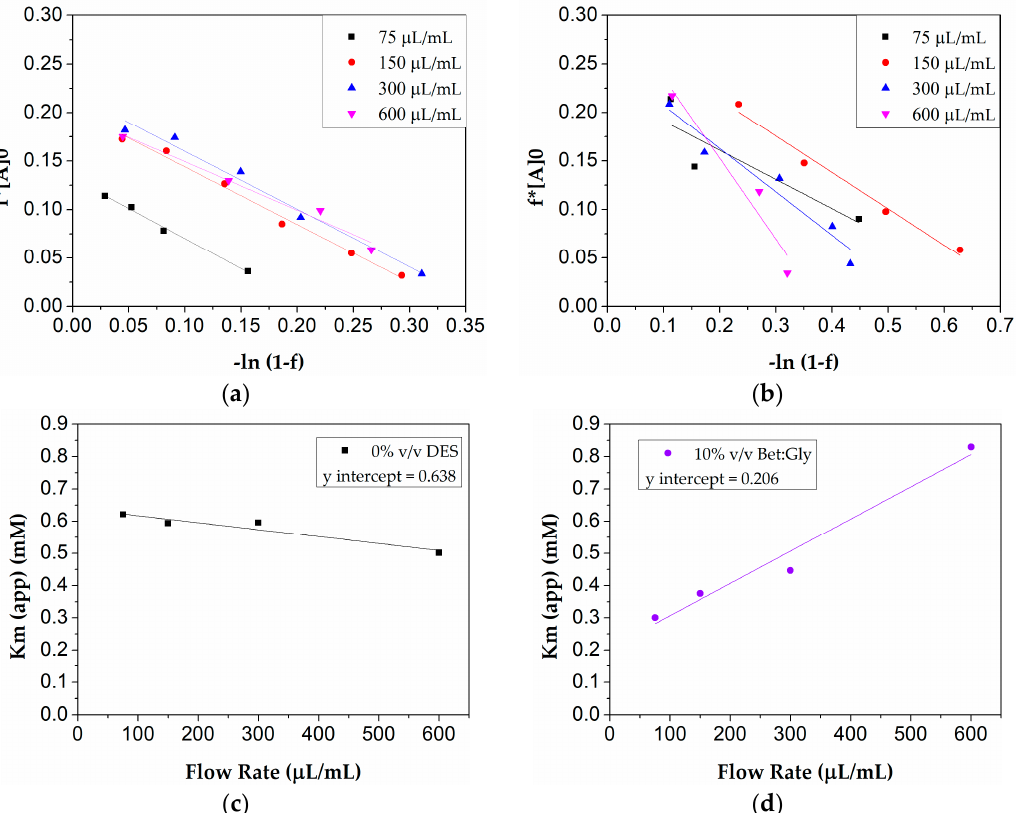
Figure 10. Effect of flow rate on the hydrolysis of p ‐ NPB in CALB immobilized microreactors under continuous flow conditions (enzyme concentration 43 μ g/mL, T = 40 °C, pH = 7.5). ( a ) Application of the Lilly–Hornby model on the data collected for different enzyme concentrations and flow rates in a buffer system (0% v / v DES), and ( b ) in 10% Bet:Gly system. ( c ) Linear fitting of the K m(app) values against flow rate in a buffer system, and ( d ) in 10% Bet:Gly system.